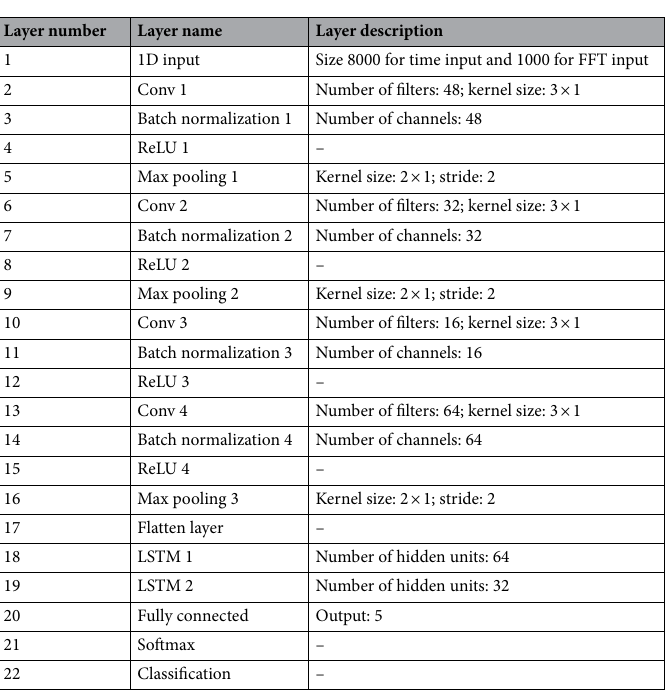
Table 4. The proposed CNN-LSTM architecture.